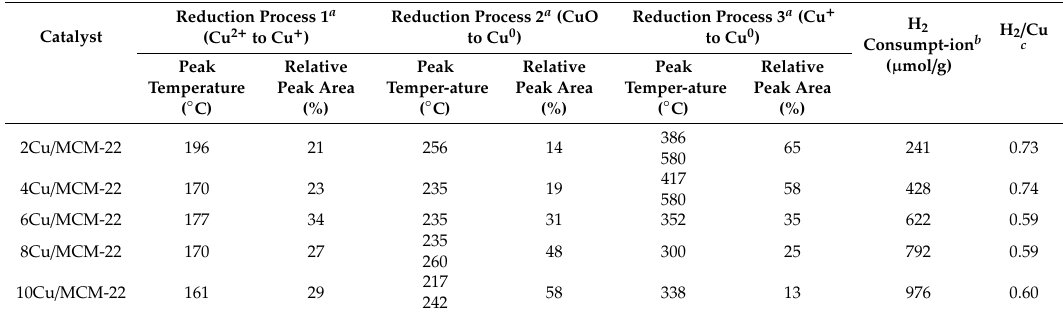
Table 3. Quantitative results of H 2 -TPR experiments in x Cu / MCM-22